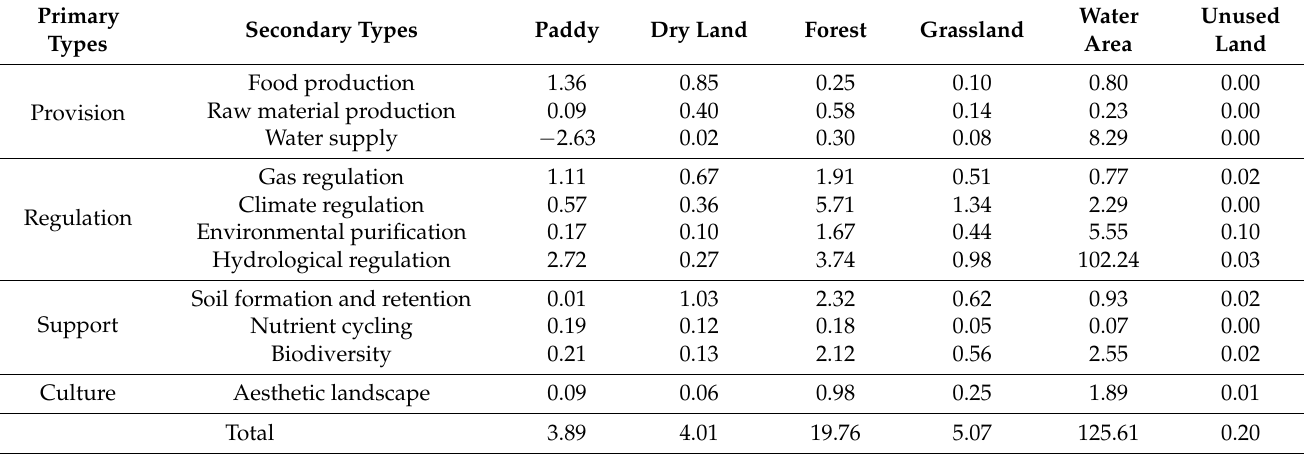
Table 1. Equivalence value per unit area of the ecological service of non-construction land in the